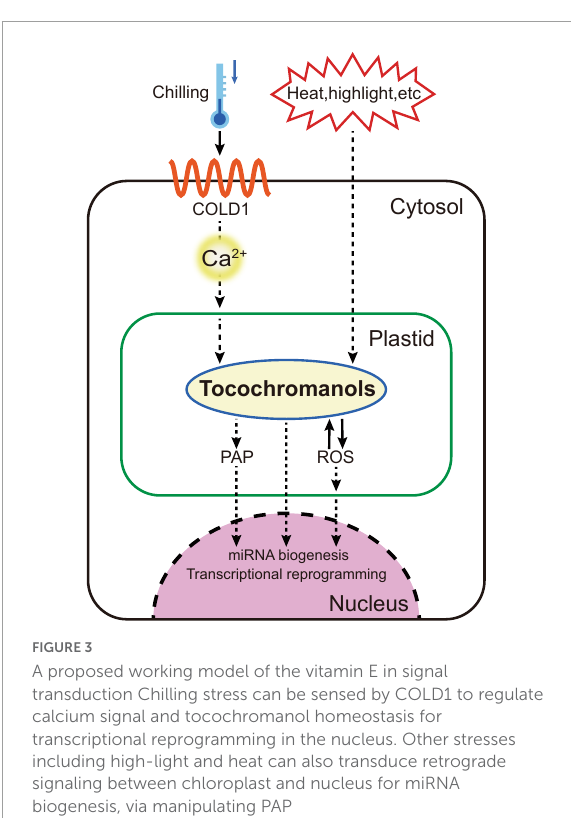
FIGURE3 A proposed working model of the vitamin E in signal transduction Chilling stress can be sensed by COLD1 to regulate calcium signal and tocochromanol homeostasis for transcriptional reprogramming in the nucleus. Other stresses including high-light and heat can also transduce retrograde signaling between chloroplast and nucleus for miRNA biogenesis, via manipulating PAP (3 (cid:48) -phosphoadenosine-5 (cid:48) -phosphate) and